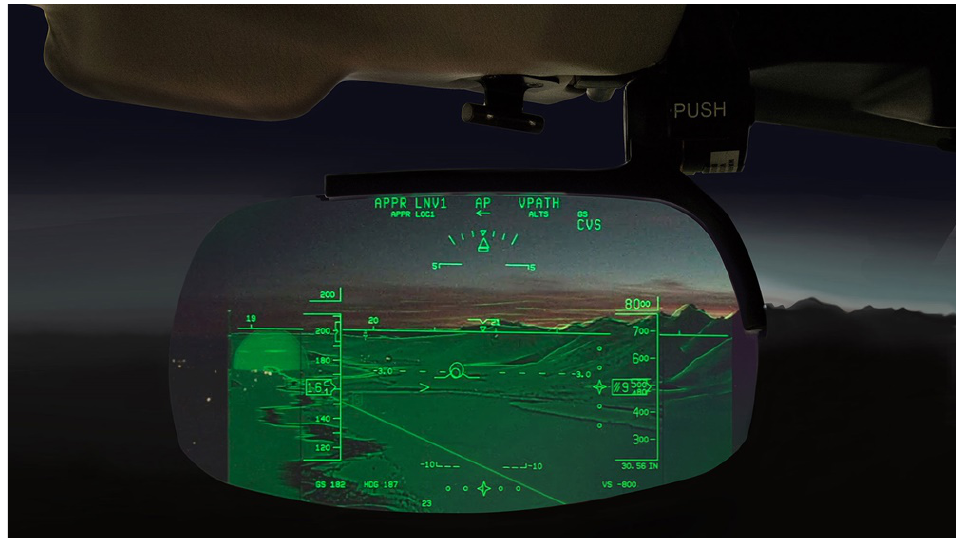
Figure 4. Collins Aerospace’s Combined Vision System